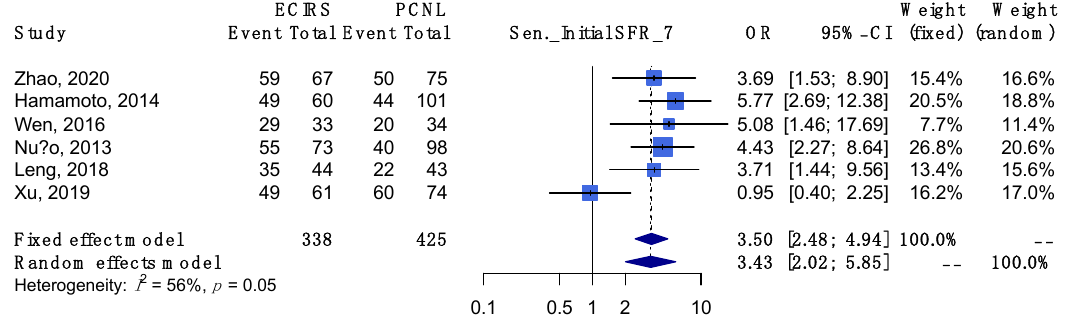
Figure A19. Sensitivity analysis of outcome regarding initial stone free rate. ([17–20,22,23]).